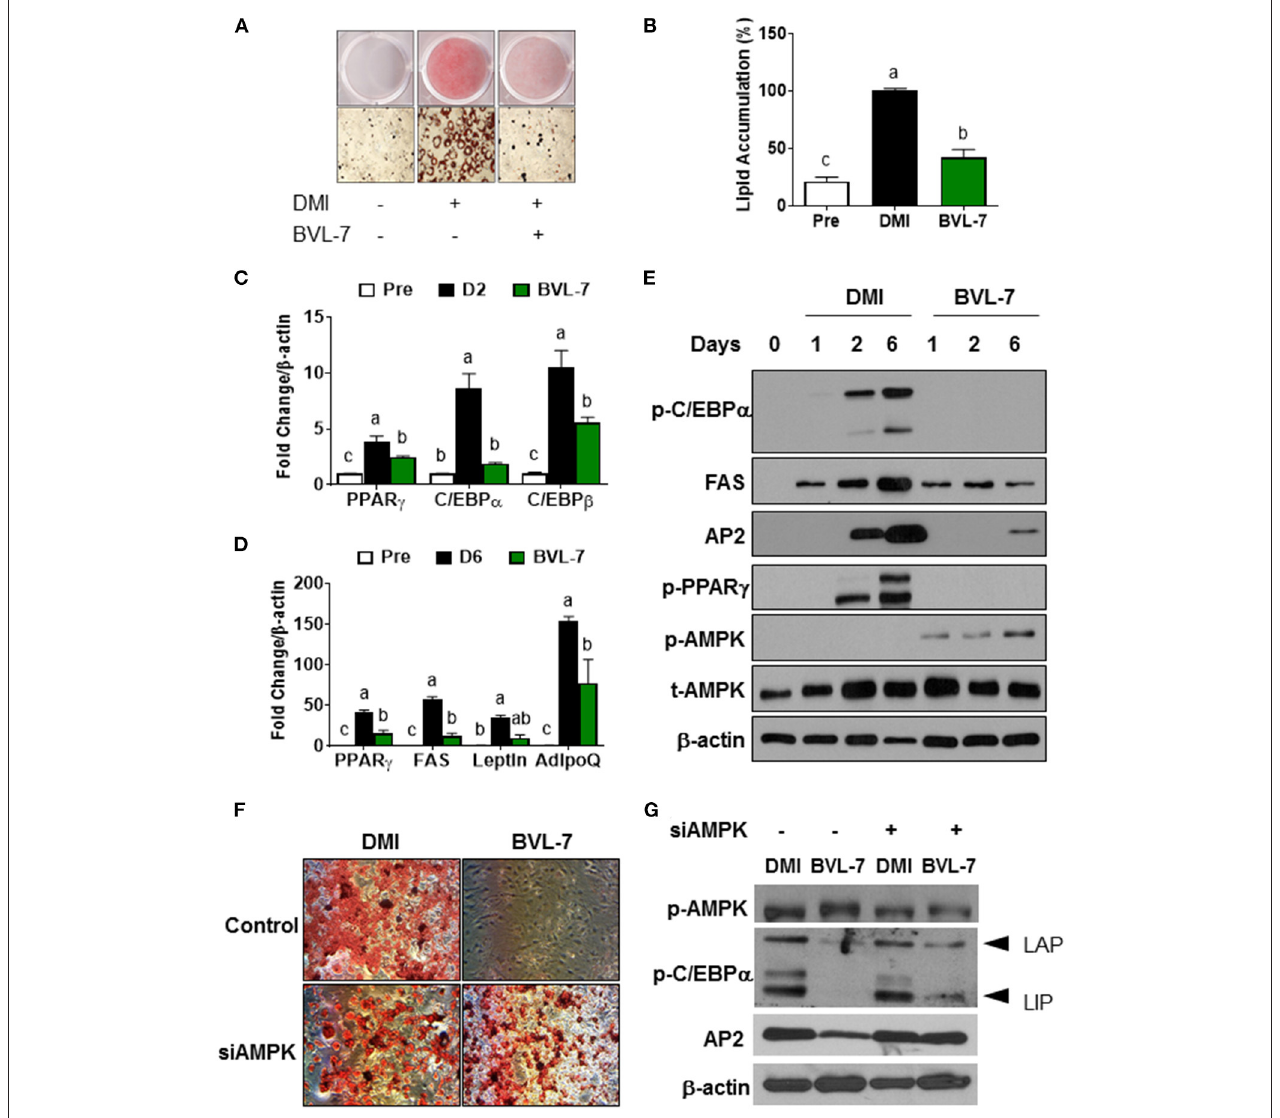
FIGURE 3 | BVL-7 inhibits adipocyte differentiation through AMPK activation. 3T3-L1 preadipocytes were differentiated with or without BVL (100 µ g/ml) at the indicated time. (A,B) The representative image and quantitative analysis of lipid accumulation from adipocytes on D6 were shown using ORO staining. (C,D) The mRNA expressions of adipocyte markers were measured on the early and late stages of differentiation, indicating D2 and D6, respectively. (E) The protein samples were collected on the indicated time points such as D1, D2, and D6. The representative image was shown. siAMPK transfection was performed in 90% confluent cells 24h before differentiation and then, the cells were differentiated to adipocytes with/without BVL. The lipid accumulation was shown using ORO staining (F) and adipogenesis-related markers as well as p-AMPK were measured by immunoblotting (G) . The values were presented using mean ± SEM and each experiment was repeated at least 3 times. Different letters were presented as statistical difference ( p <